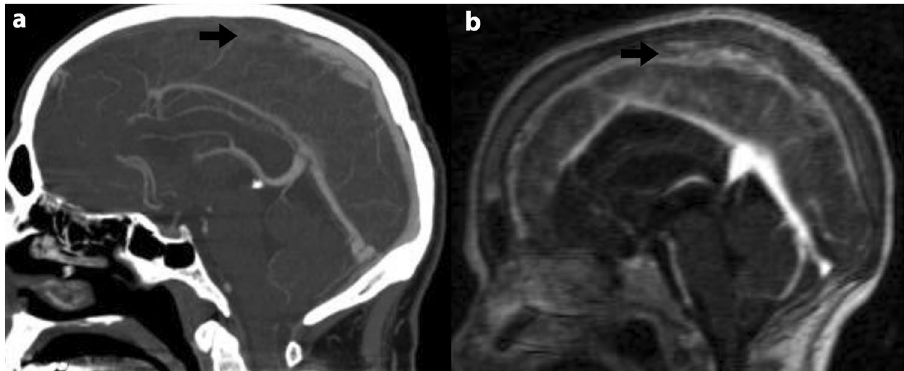
Figure 2. False negative CTA reading in a 38 y/o woman with CVT. The Sagittal reconstruction CTA ( a ) shows an irregular filling defect within the superior sagittal sinus (black arrow) that was missed by the readers. The filling defect (white arrow) is also seen in the sagittal MR